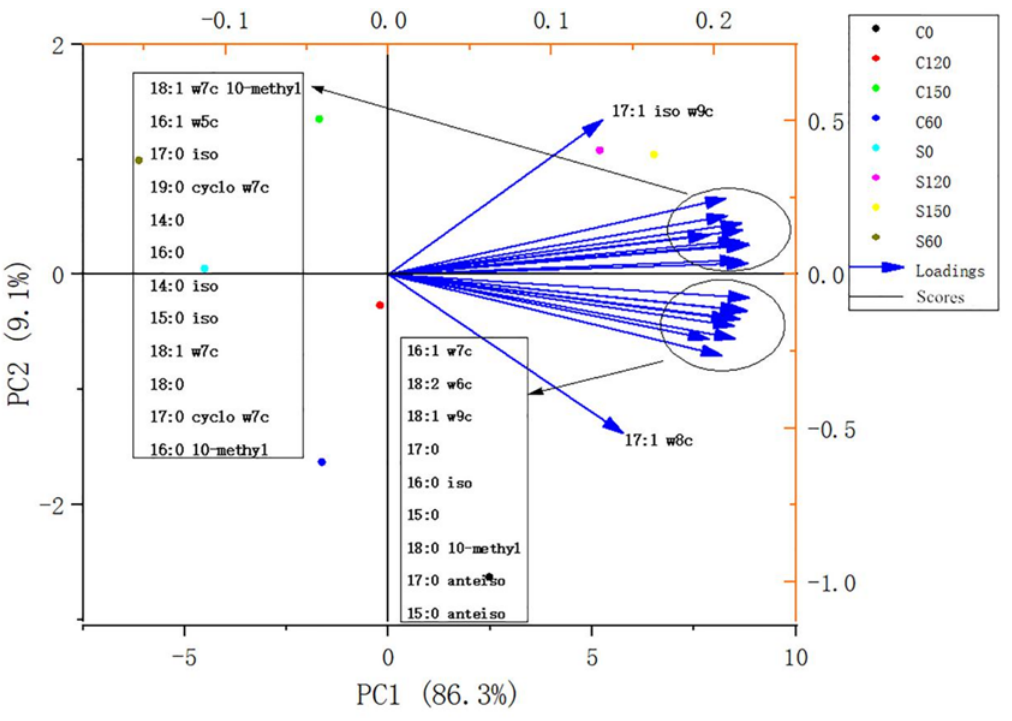
Figure 1. PCA analysis chart. The horizontal axis is the first principal component (PC1), and the vertical axis is the second principal component (PC2). C indicates that E. purpurea was not planted, and S indicates that E. purpurea was planted. C0, C60, C120, C150, S0, S60, S120, and S150 represent soil samples at 0, 60, 120, and 150 days before and after planting, respectively.